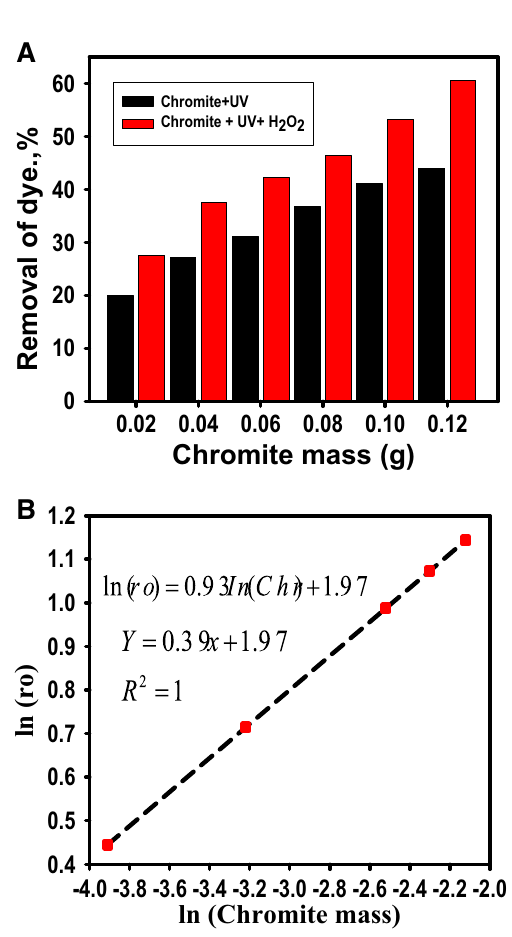
Fig. 5 a The effect of chromite mass on the degradation of Congo red dye, b the relation between r o and the chromite mass